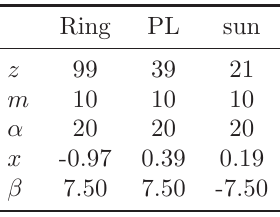
Figure 8: Axial deformation as function of angular po-